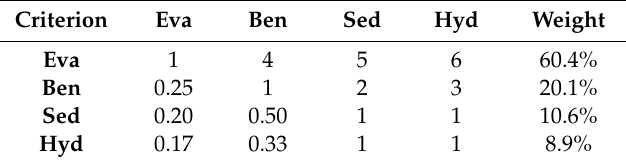
Table 2. Pairwise comparison matrix and weight using analytic hierarchy process (AHP).